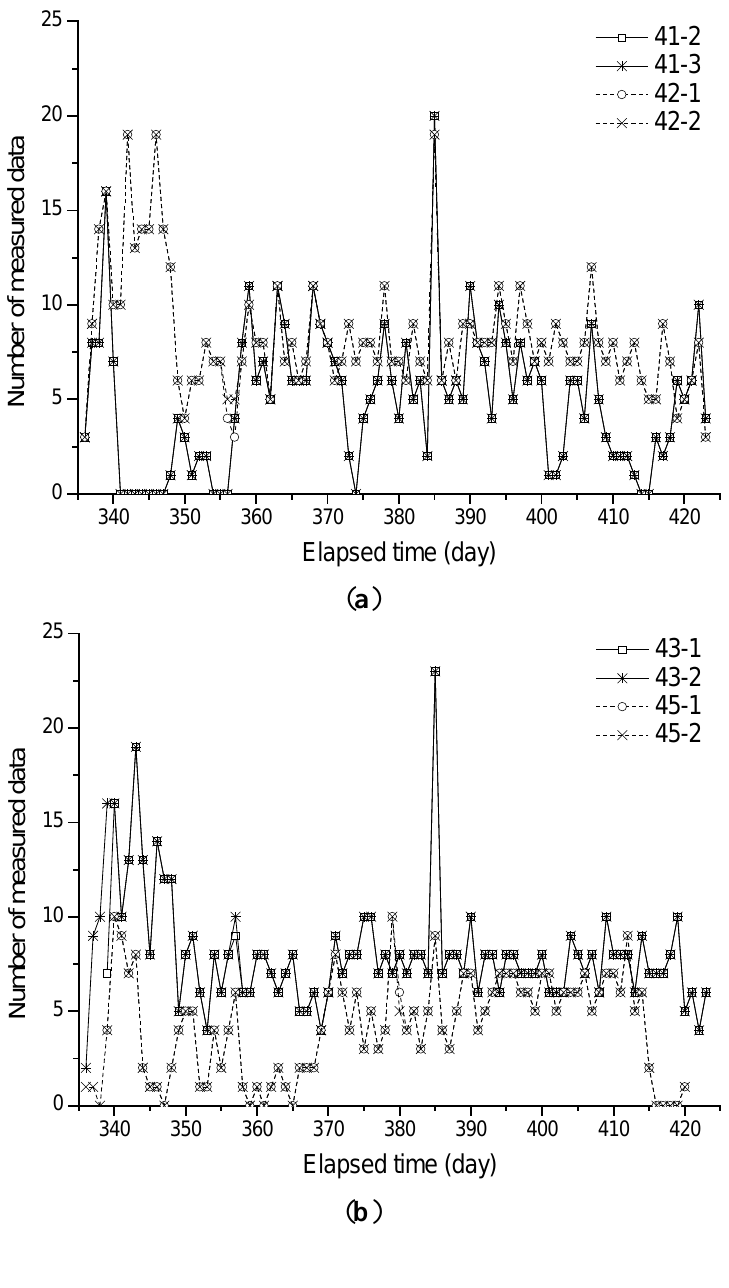
Figure 15. The daily data history for sensors on the 10th floor of towers 1 and 2. ( a ) 10th floor of tower 1; ( b ) 10th floor of tower